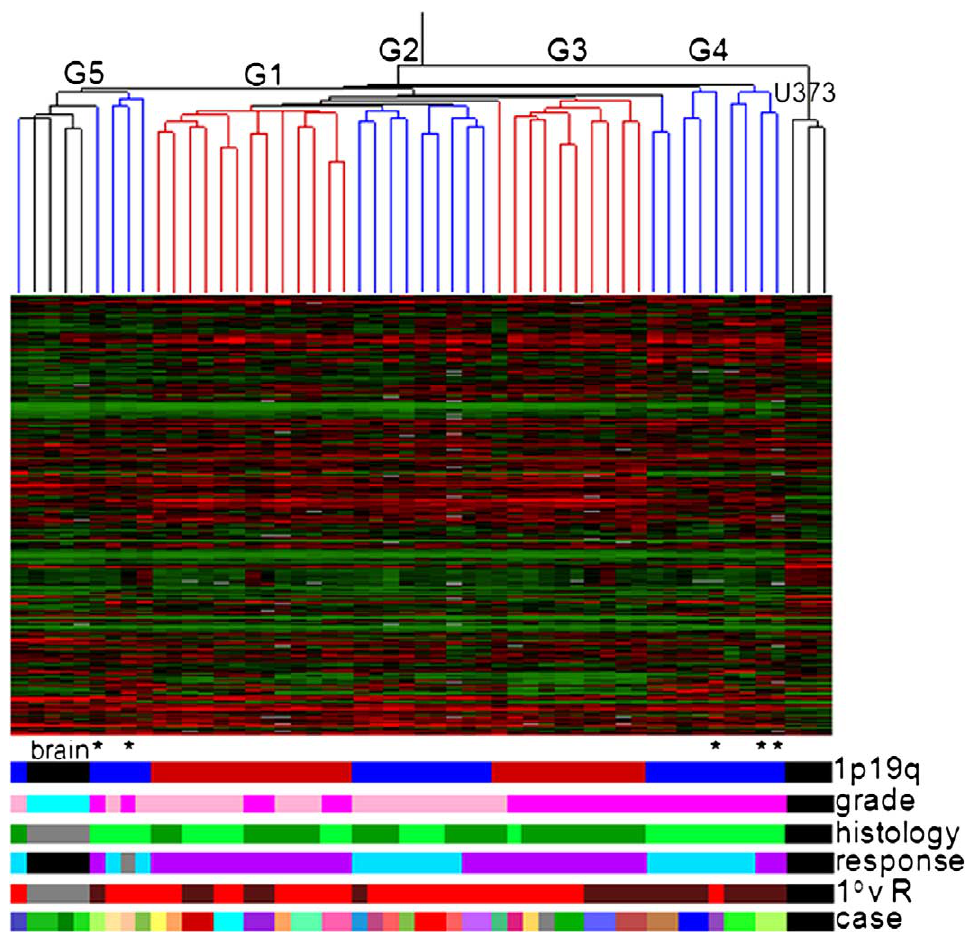
Fig. 1. Gene expression analysis. Hierarchical clustering was performed to cluster individual samples based on the similarity of their A probe-set gene expression profiles using Pearson correlation as a similarity measure with average linkage and the 3719 reliable probes. Samples are shown across the top and dendrogram branches are colored by 1p / 19q status: red, 1p / 19q loss; blue, 1p / 19q intact; black, non-neoplastic brain and U373 cell line samples. Genes are represented by rows and show expression levels relative to reference for each sample: red increased, green decreased and black similar expression. Status bars indicate: 1p / 19q genotype – 1p / 19q loss, 1p / 19q intact, non-neoplastic brain and U373; grade – grade II, grade III, normal; histology – oligodendroglioma, oligoastrocytoma, normal; response – no, yes, unknown; 1 ◦ v R – primary tumor, recurrent tumor, oligodendroglial component following the WHO 2007 classification of CNS tumors are